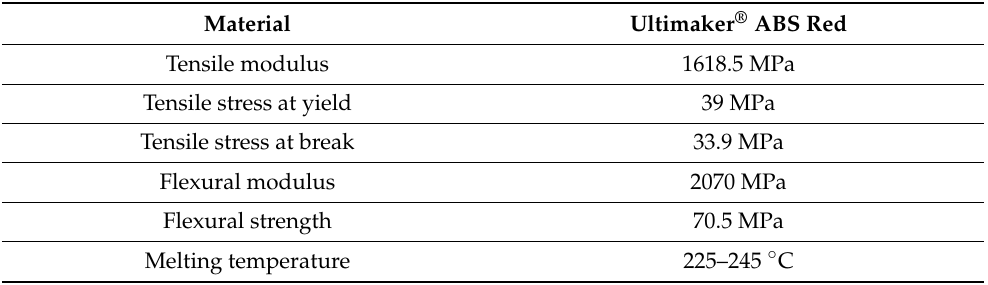
Table 1. Some properties of FDM ABS filament.